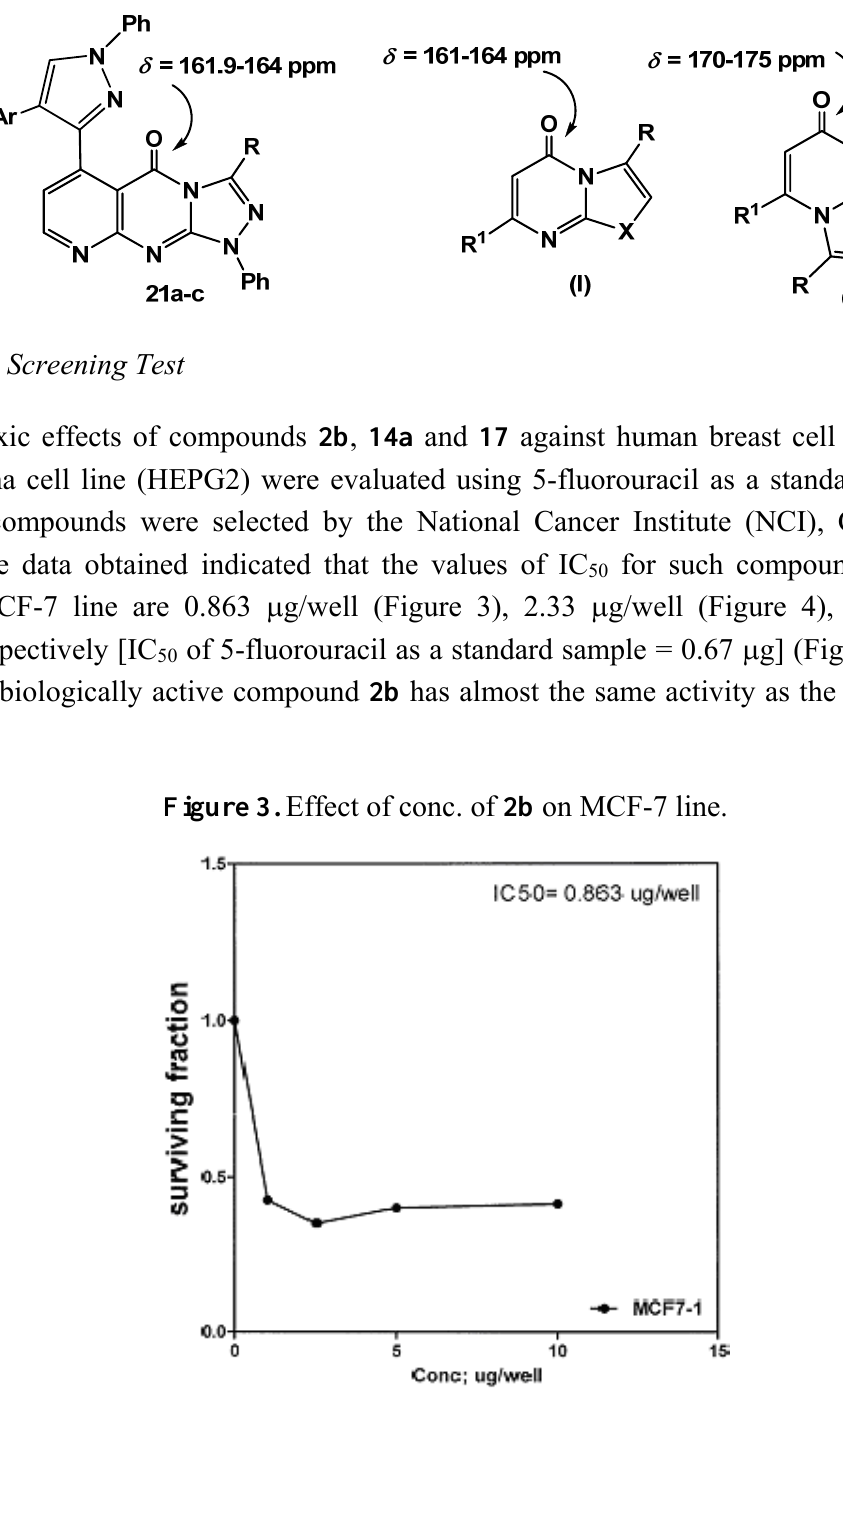
Figure 2. 13 C NMR for azolopyrimidinones.